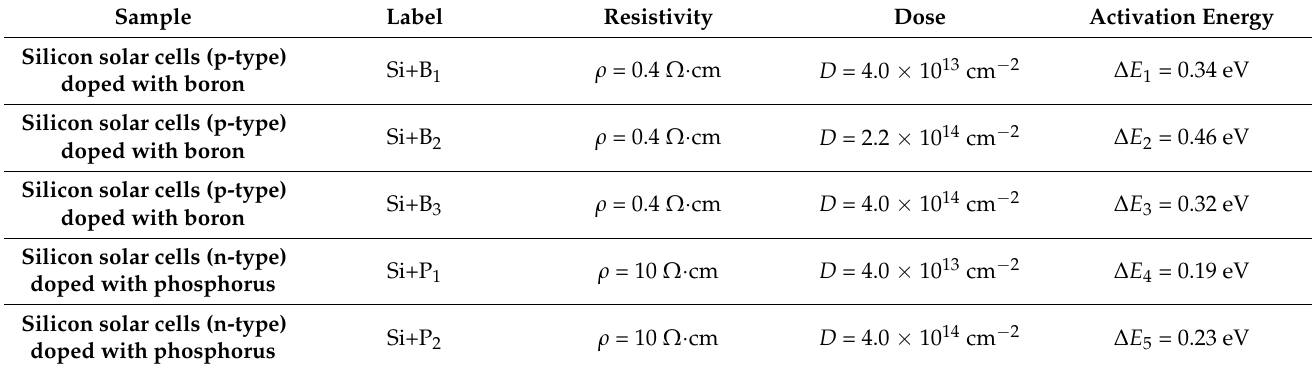
Table 1. Determination of intermediate energy levels for boron and phosphorus doped silicon sam- ples implanted with Ne + ions and energy E = 100 keV, isochronically annealed at 598 K [86,87].